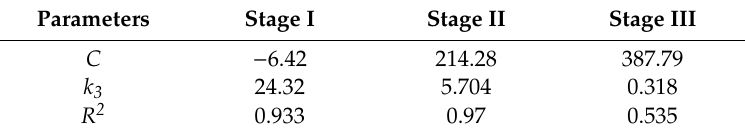
Table 2. The parameters of three stages in intraparticle diffusion model.